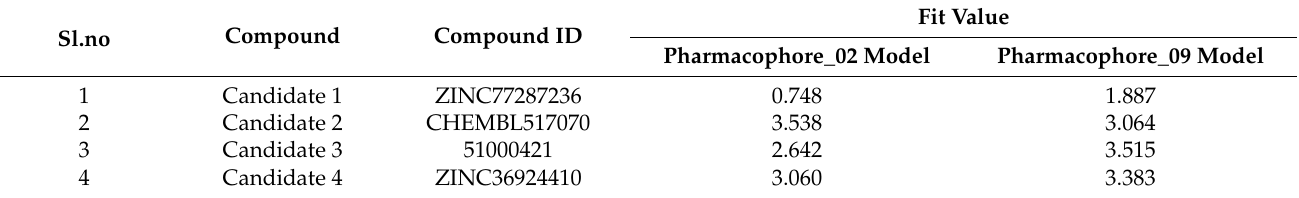
Figure 5. The structure-based pharmacophore model identified candidates; ( a ) 2D structure of iden- tified virtual hit candidates, ( b ) pharmacophore_02 model (AAAADH) aligns to the identified hit candidates, ( c ) pharmacophore_09 model (AHHH) aligns to the identified virtual hit candidates. Table 2. Fit value of identified candidates mapped to pharmacophore